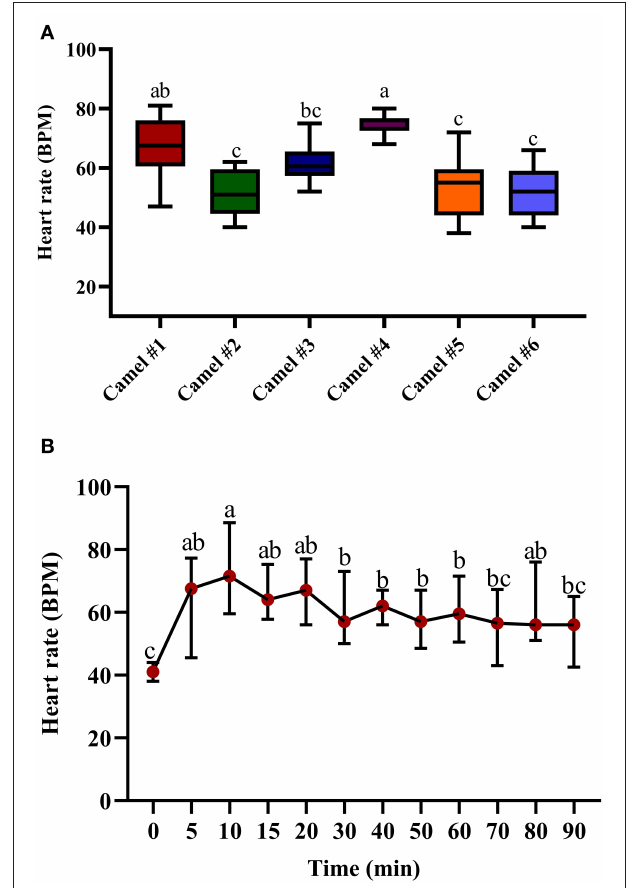
FIGURE 3 | The changes in heart rate (beats/min) in camels after injection of acepromazine (0.1 mg/kg i.v.). (A) Boxplot showing heart rate (beats/min) values with all data points represented. (B) The median heart rates 90min after acepromazine injection. Median values in each plot followed by a different lowercase letter (a, b, c) are significantly different by the Duncan test at p ≤